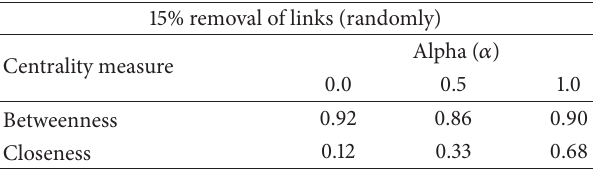
Figure 3: Targeted versus random removal of links (Betweenness centrality